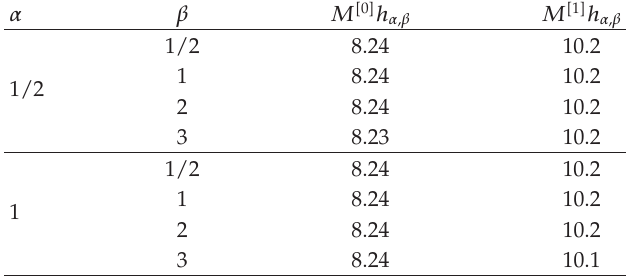
Table 1: Maximum relative % errors of the presented approximate solution h α,β (cid:3) x (cid:4) and its derivative for the sample points x j (cid:5) (cid:3) 0 . 2 (cid:4) j , j (cid:5) 1 , 2 ,..., 50. α